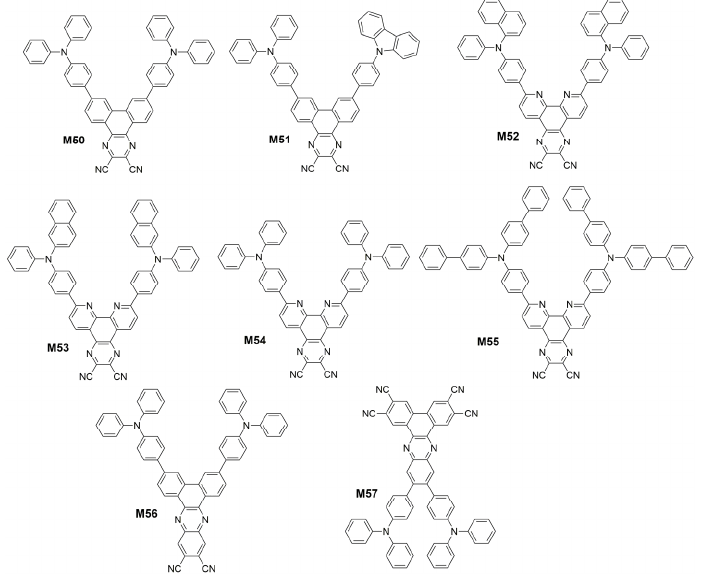
Figure 17. Chemical structures of M50 to M57 .